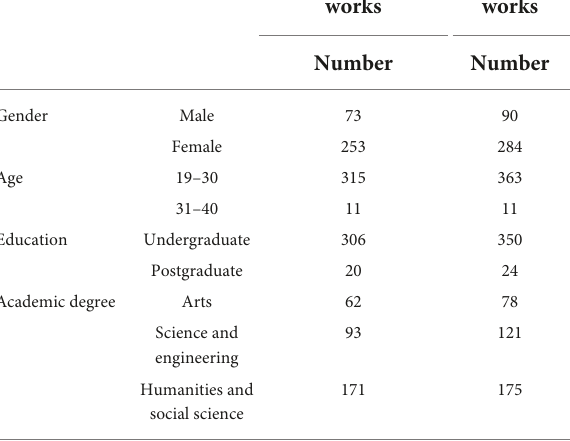
TABLE 3 Profile of the